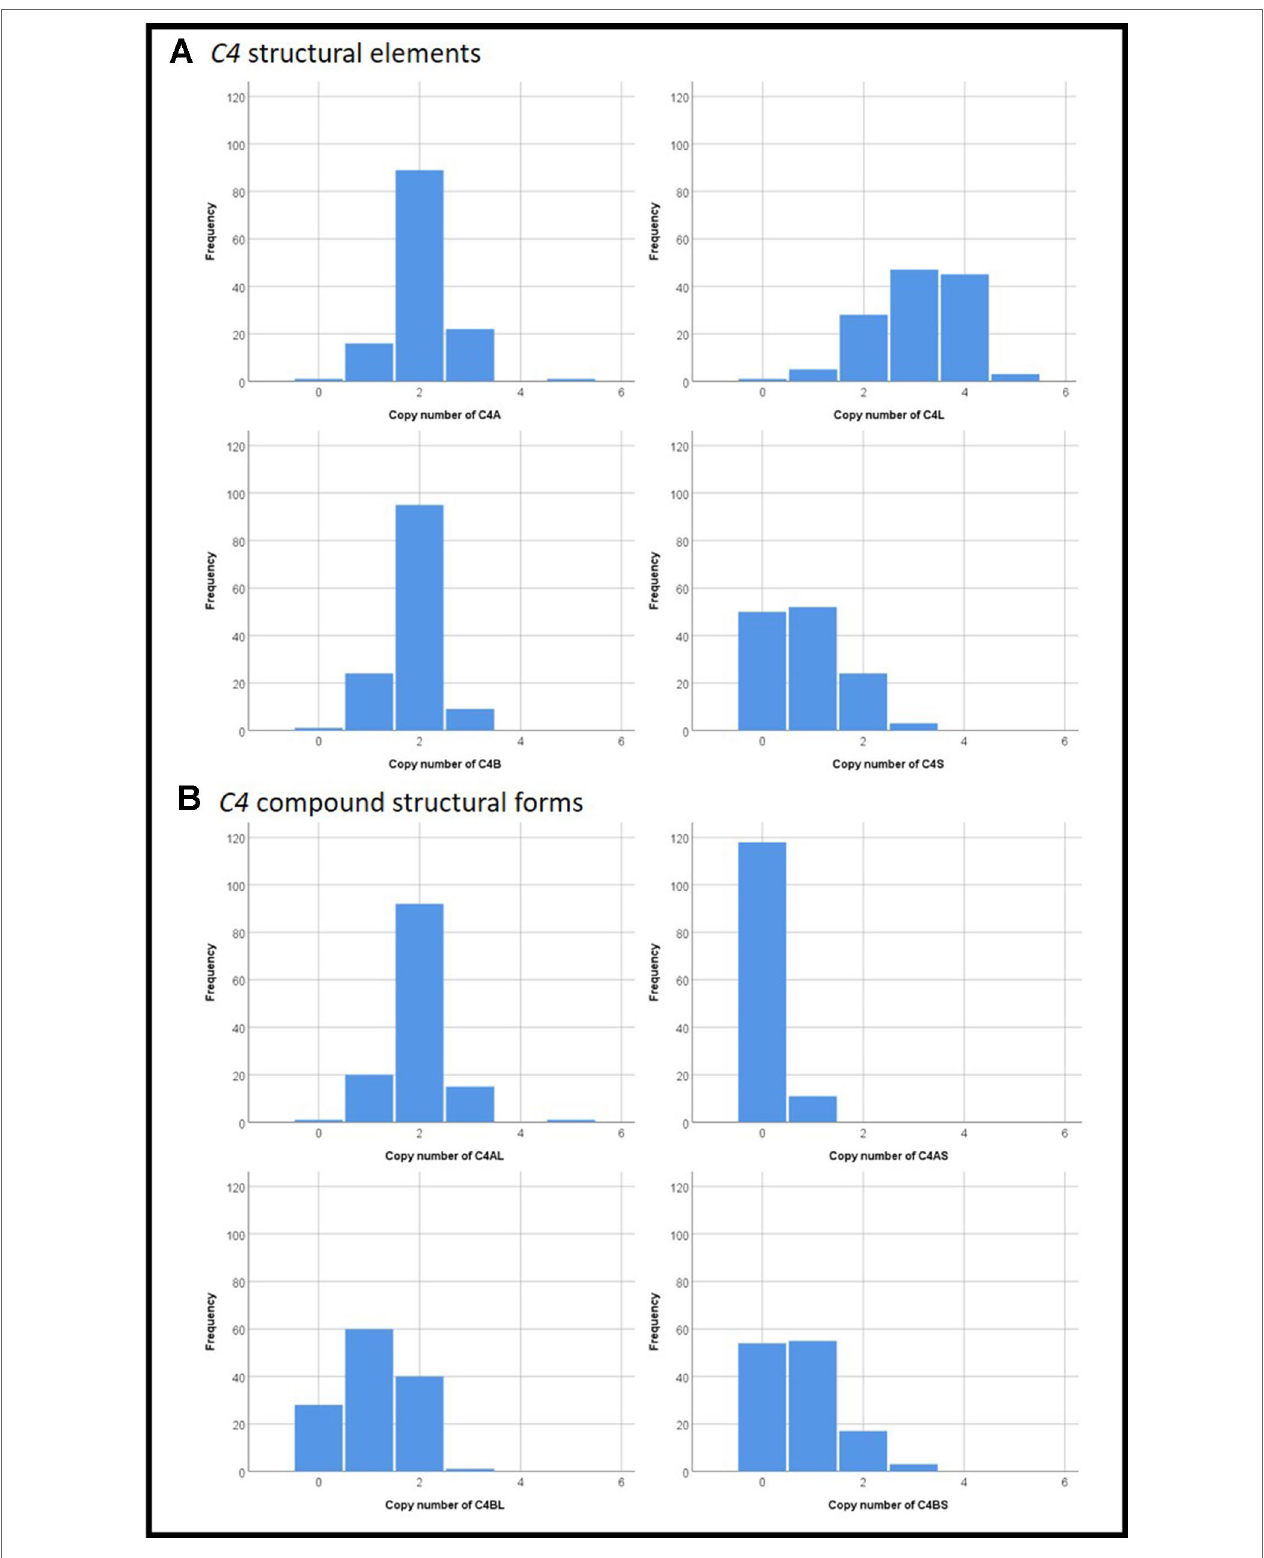
FIGURe 1 | Distributions of copy numbers of the various C4 (A) structural elements and (B) compound structural forms in our study sample.